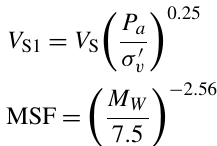
Table 1. Reference list of acronyms used in this